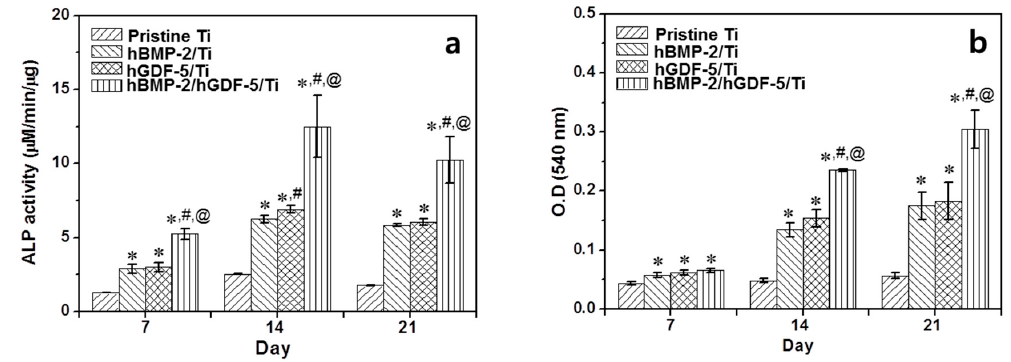
Figure 6. ( a ) Level of ALP activity; and ( b ) the amount of calcium deposition on pristine Ti, hBMP-2/Ti, hGDF-5/Ti, and hBMP-2/hGDF-5/Ti samples cultured with MC3T3-E1 cells for 7, 14, and 21 days, as compared to those on pristine Ti. The error bars represent mean ± SD ( n = 3). These experiments were repeated three times (* p < 0.05, # p < 0.05, and @ p < 0.05). Controls of the p values were pristine Ti, hBMP-2/Ti, and hGDF-5/Ti, respectively.